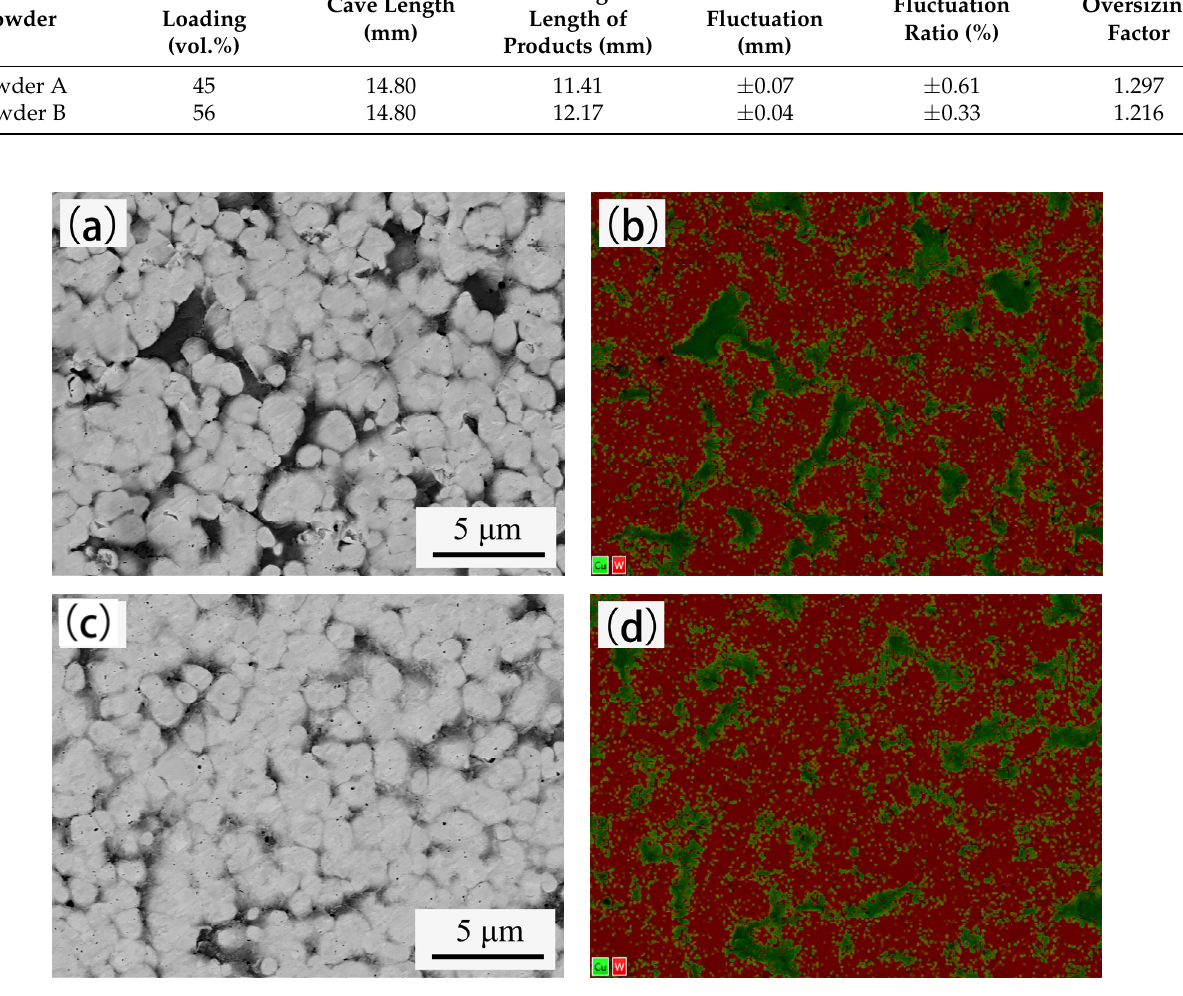
8 of 12 Figure 6. Test samples produced via PIM ( a ) green part; ( b ) sintered part after polish. Table 3 shows the effect of powder loading on the dimension precision and OSF of the supporter parts. The lengths of the cave and supporter parts were measured to evalu- ate the dimension fluctuation and OSF. When the powder loading increases from 45% to 56%, the OSF decreases from 1.297 to 1.216, and the dimension fluctuation ratio decreases from ±0.61% to ±0.33%. The results show that the dimensional accuracy of the products